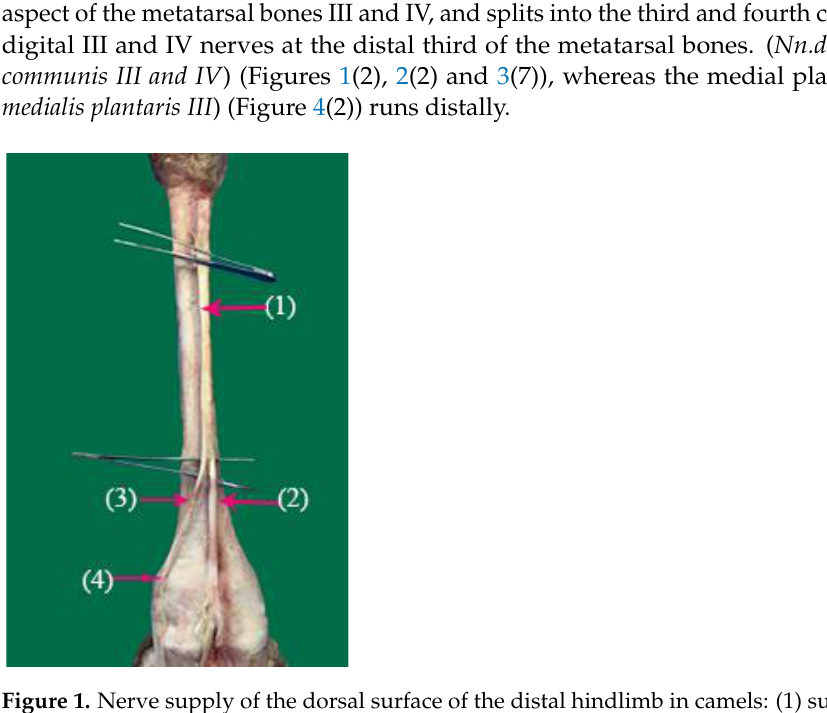
Figure 2. Nerve supply of the dorsal surface of the phalanx of the hindlimb in camels: (1) superficial fibular nerve; (2) common dorsal digital nerve of the third digit; (3) common dorsal digital nerve of the fourth digit; (4) abaxial dorsal proper digital IV nerve; (5) axial dorsal proper digital IV nerve; (6) abaxial dorsal proper digital III nerve.